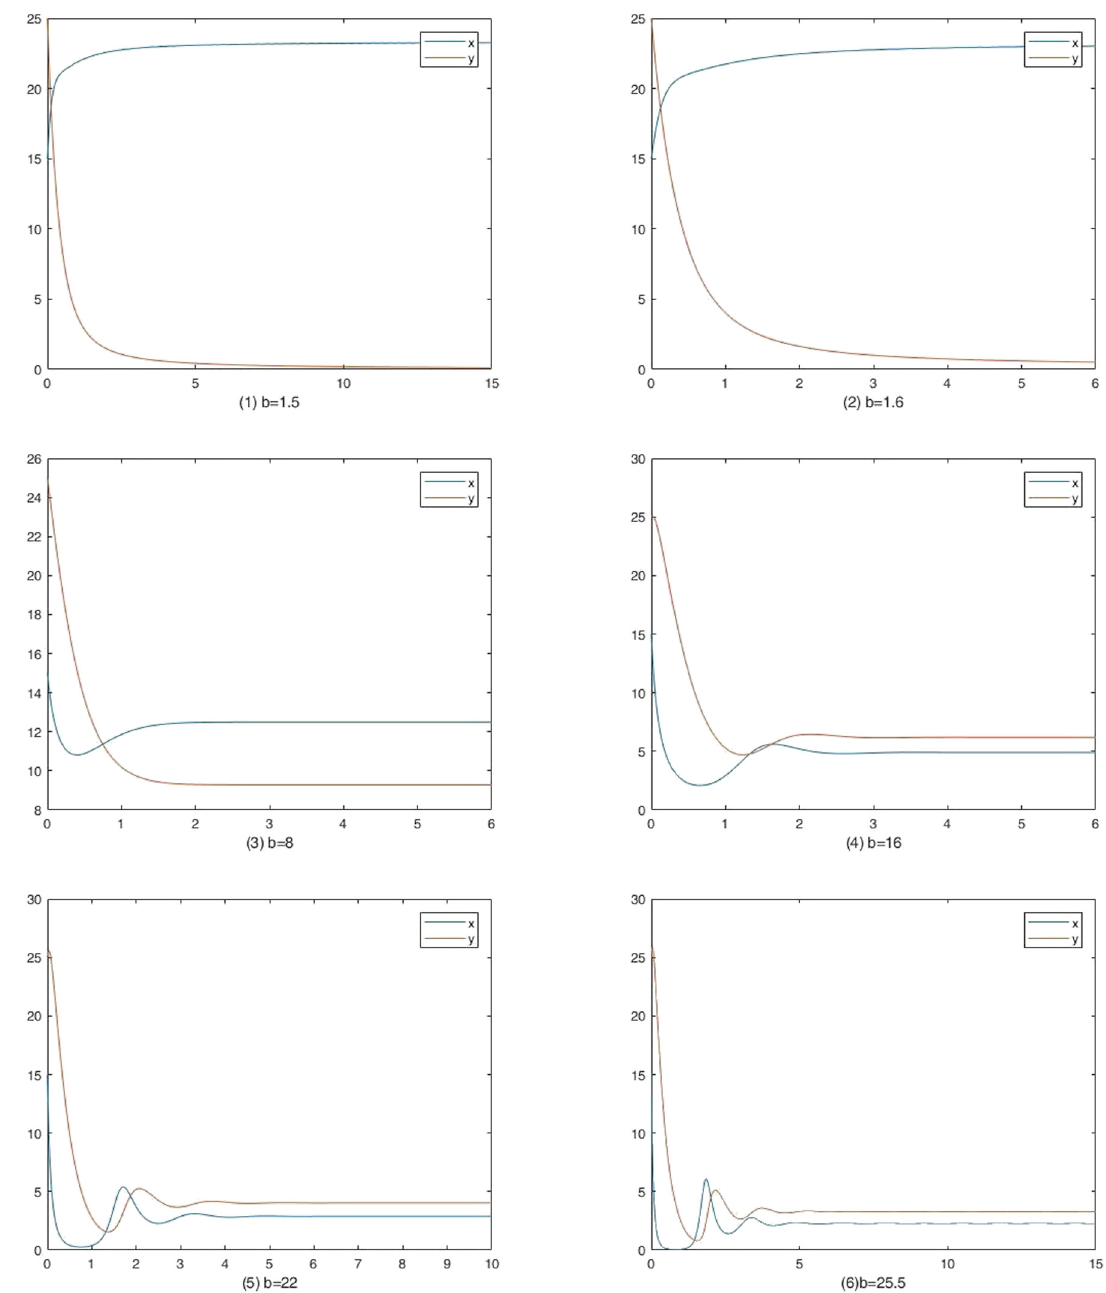
Figure 2: Persistence with di ff erent predation